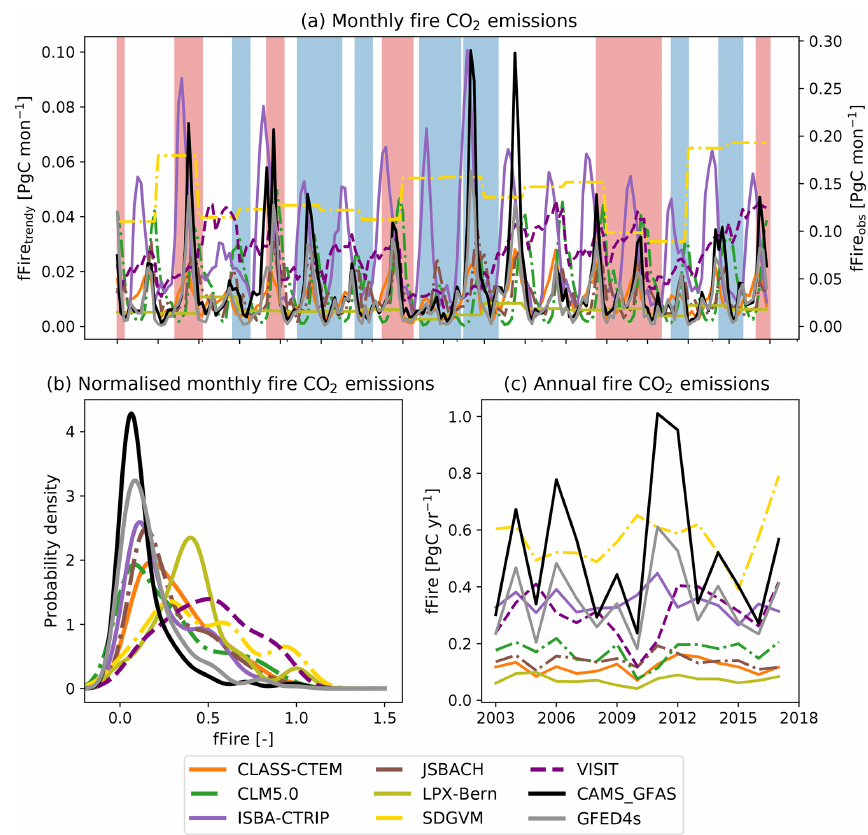
Figure 7. Monthly (a, b) and annual (c) fire CO 2 emissions of seven TRENDY models and two satellite-derived estimates (CMAS-GFAS and GFED4s). Shaded blue areas show La Niña events; shaded red areas show El Niño events. Panels (a) and (c) show the total fire CO 2 emissions; (b) shows the probability density function based on kernel density estimates using Gaussian kernels with bandwidth selection following Scott (1992) of the normalized monthly fire CO 2 emissions. Note that the satellite-derived estimates have a different y axis for the monthly fire CO 2 emissions than for the TRENDY